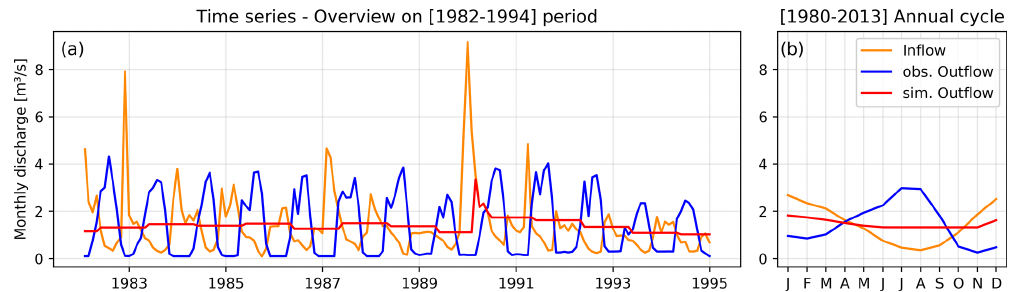
Figure 13. Example of time series (a) and monthly means (b) of simulated releases from Los Bermejales reservoir, a multi-purpose reservoir primarily used for water supply and which also operates to meet irrigation water demands. The reservoir model failed to reproduce observed irrigation releases as it does not consider secondary